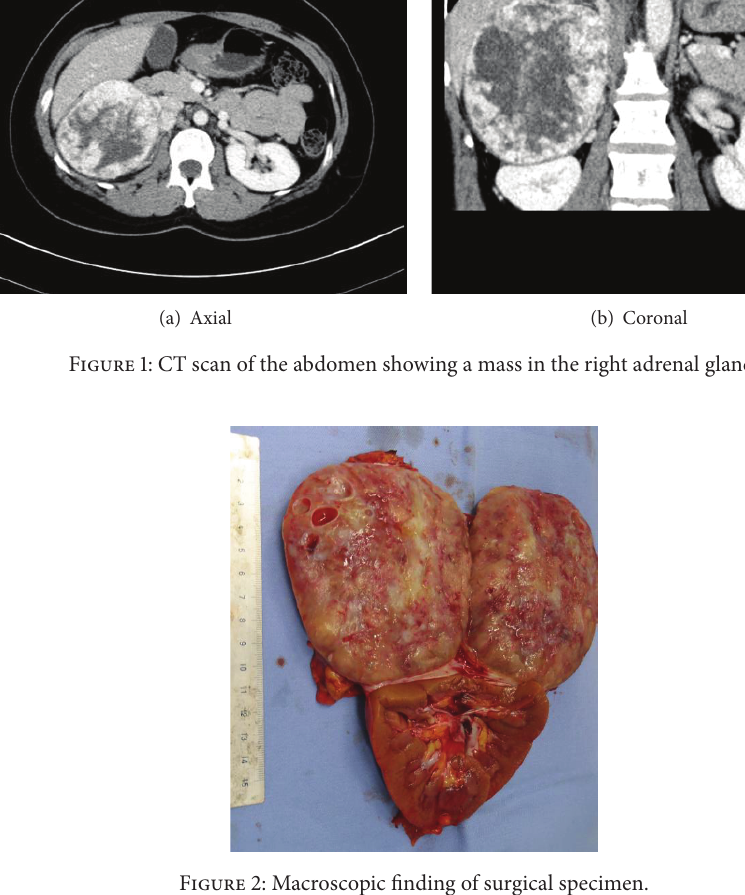
Figure 2: Macroscopic finding of surgical